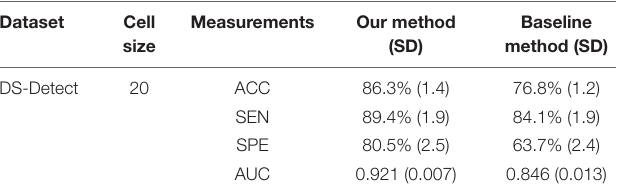
TABLE 1 | Comparison of the glioma detection performance evaluated by 10-fold cross-validation between the baseline concatenating HOG method and our proposed transformed HOG method.